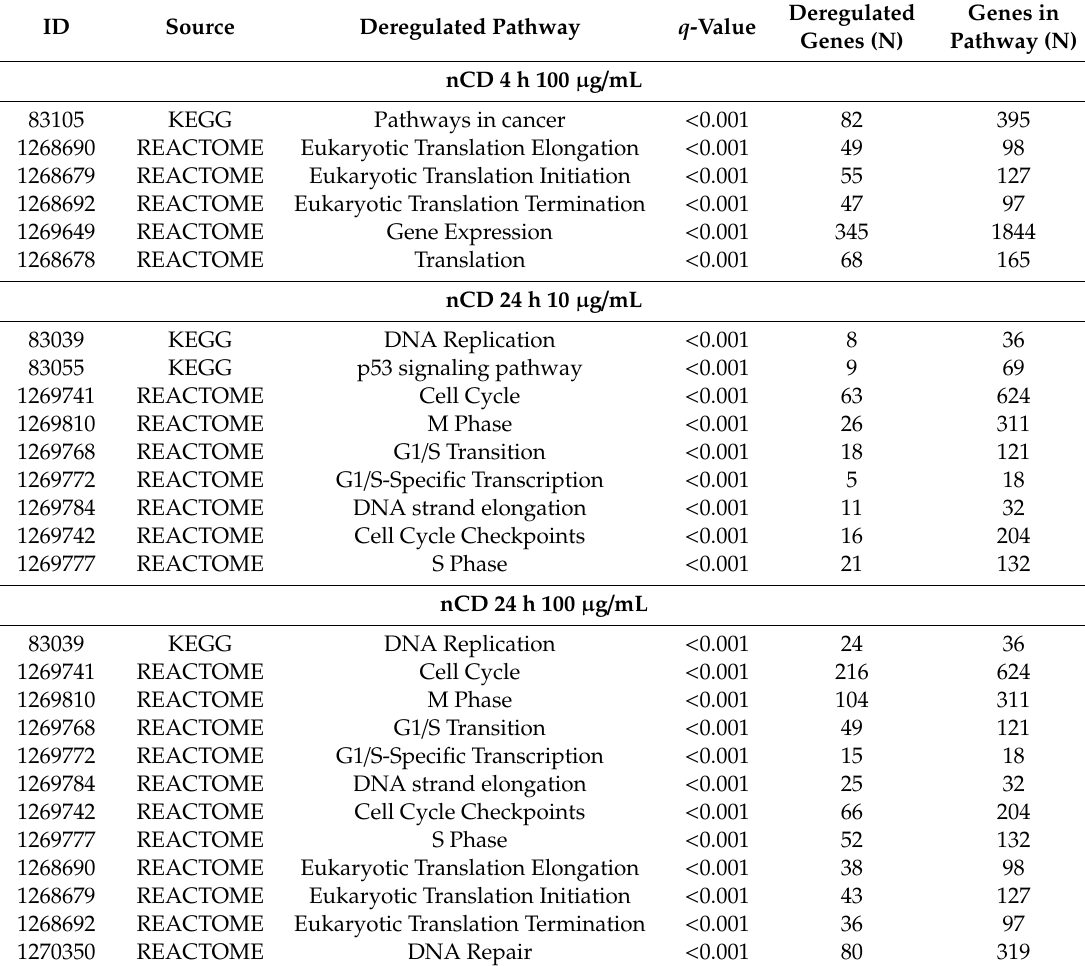
Table 2. Selected pathways deregulated after nCD NPs